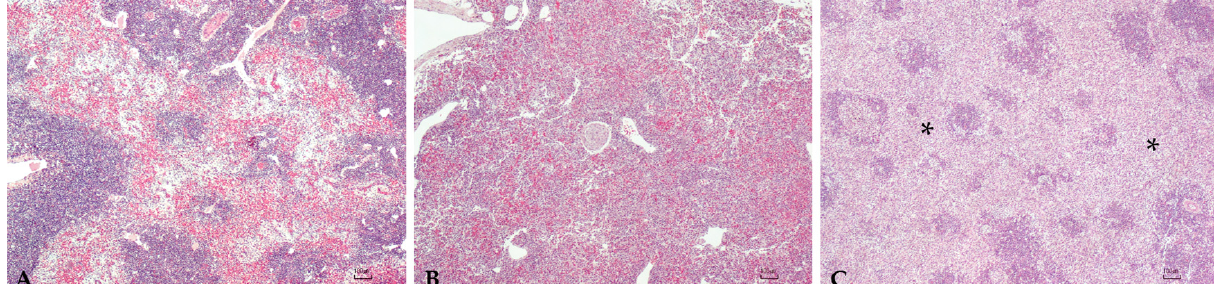
Figure 2. Spleen: Mild ( A ), moderate ( B ), and severe ( C ) granulomatous chronic splenitis mainly involving the red pulp (asterisk ( C )), constituted of a high number of activated macrophages. H.E. Bar ( A – C ) = 100 µ m.